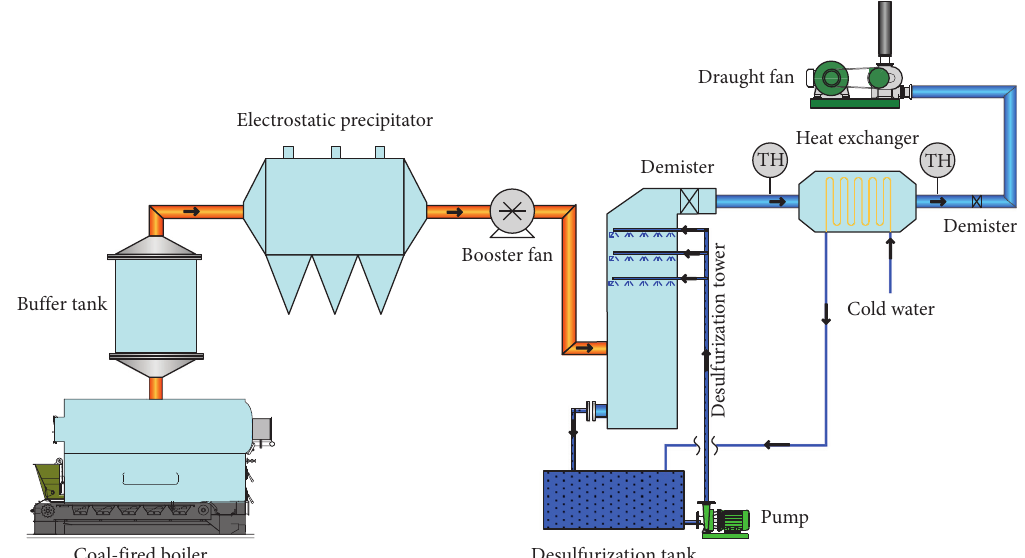
Figure 1: Schematic diagram of experimental